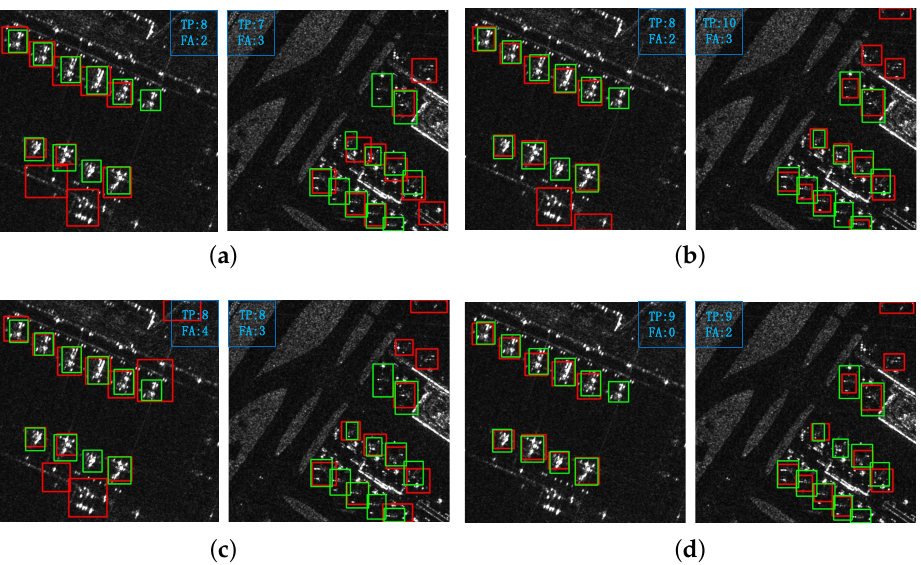
Figure 11. The detection results reported in Table 3. The red boxes represent the detection results and the green boxes represent the ground truth. We count the evaluation results in blue boxes. TP means accurately predicted targets and FA means false alarms. ( a ) tiny. ( b ) +RB. ( c ) +ICB. ( d ) LDM.